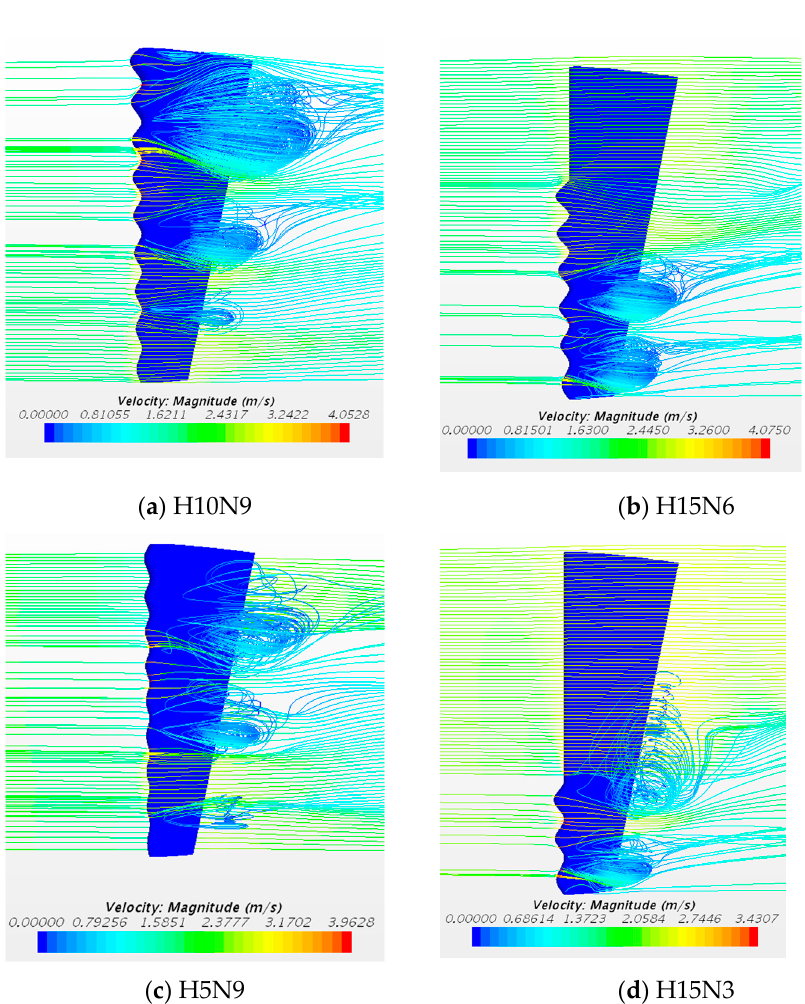
iso-surfaces in ( a ) corresponds to Q = 150 and velocity magnitude contour of streamline in ( b )).